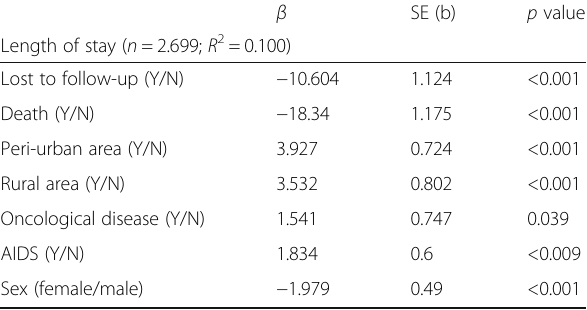
Table 4 Comparison of LOS stratified by sociodemographic characteristics, outcome and chronic diseases β SE (b) p value Length of stay ( n = 2.699; R 2 = 0.100)